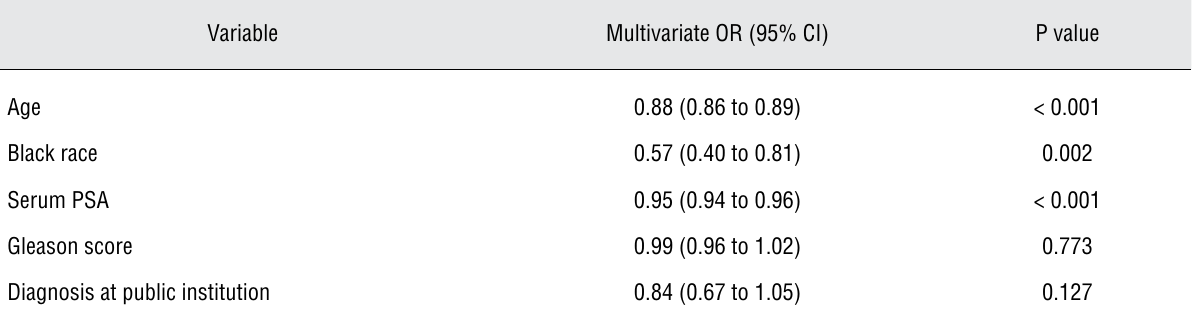
Table 4 - Multivariate analysis of factors associated with prostatectomy as initial treatment in the total sample of 1915 patients.